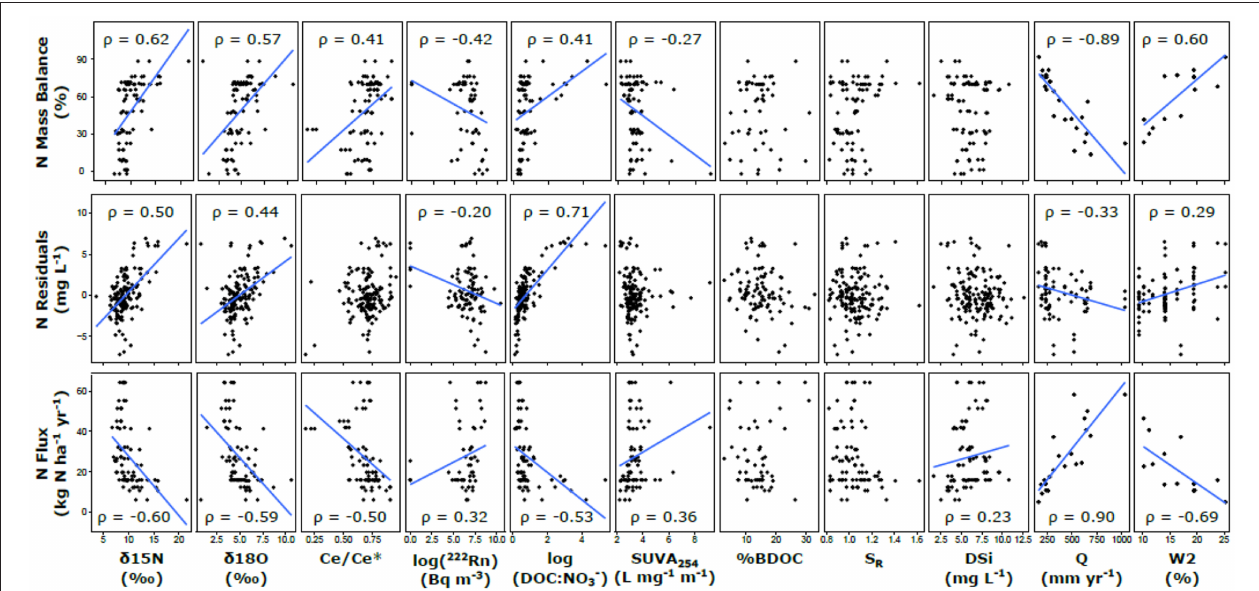
FIGURE 7 | Correlation analysis of N attenuation metrics and biogeochemical proxies. Trend lines are shown when p < 0.05 for Spearman rank correlations between the parameters (relationships are not necessarily linear). This non-parametric test is robust to non-linearity in the relationships, which are only depicted linearly to indicate direction of the relationship.